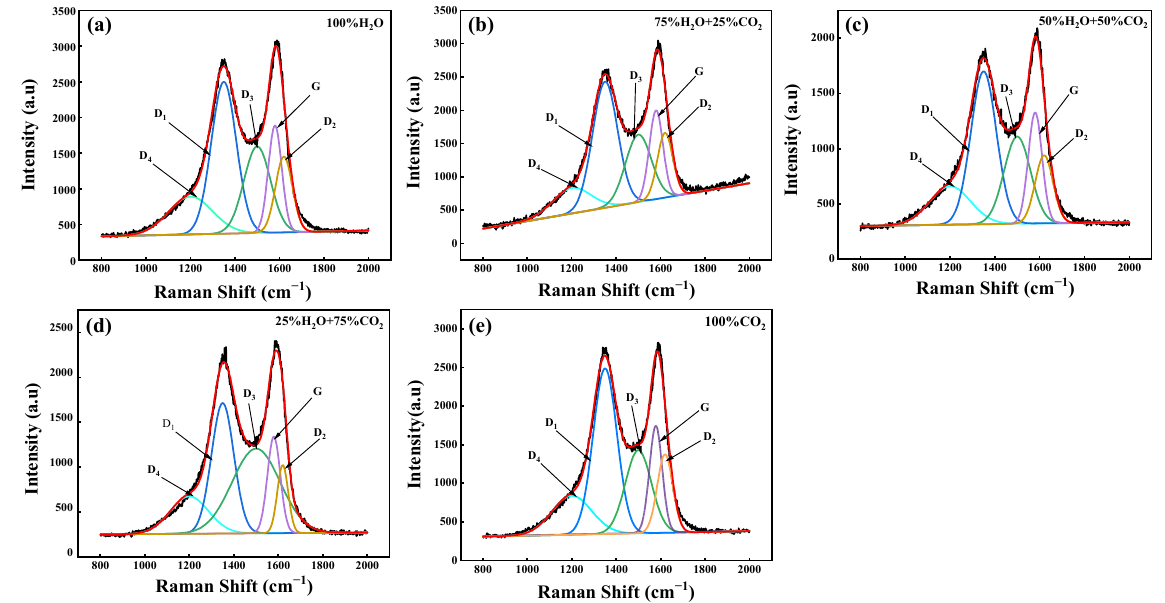
Figure 8. Peak-fitting diagram after the reaction of CO 2 and H 2 O. ( a ) 100 %H 2 O; ( b ) 75%H 2 O + 25%CO 2 ; ( c ) 50%H 2 O + 50%CO 2 ; ( d ) 25%H 2 O + 75%CO 2 ; ( e ) 100%CO 2 . Table 4. Calculation results of peak area obtained by fitting from Figure 8.